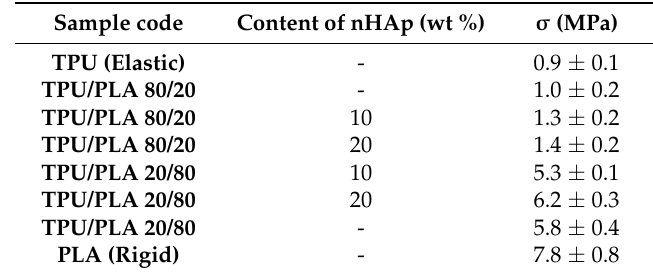
Table 9. Mechanical properties of the blend of TPU and PLA doped with nano-hydroxyapatite in comparison with pure polyurethane and polylactide—compressive test.